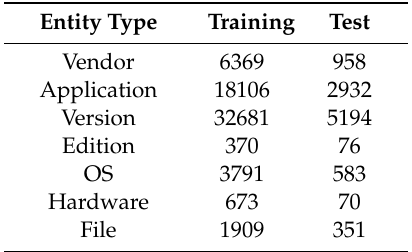
Table 1. Named entity recognition (NER) corpus statistics.